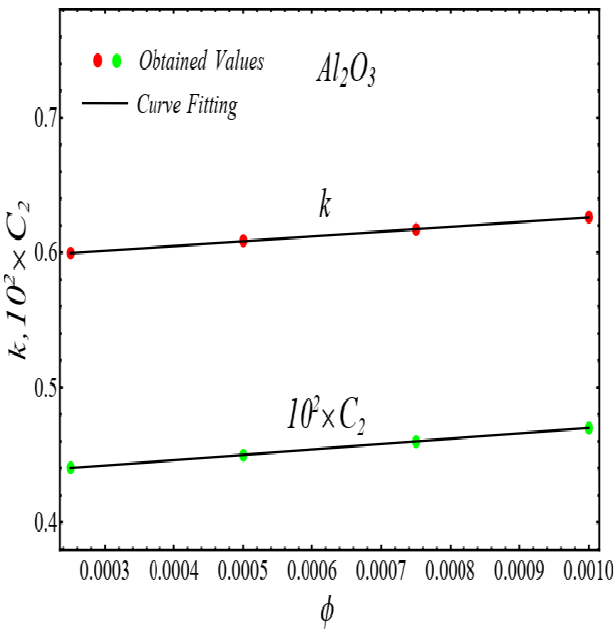
Figure 14. Fitting of the Equation (4) for parameters listed in Table 3.